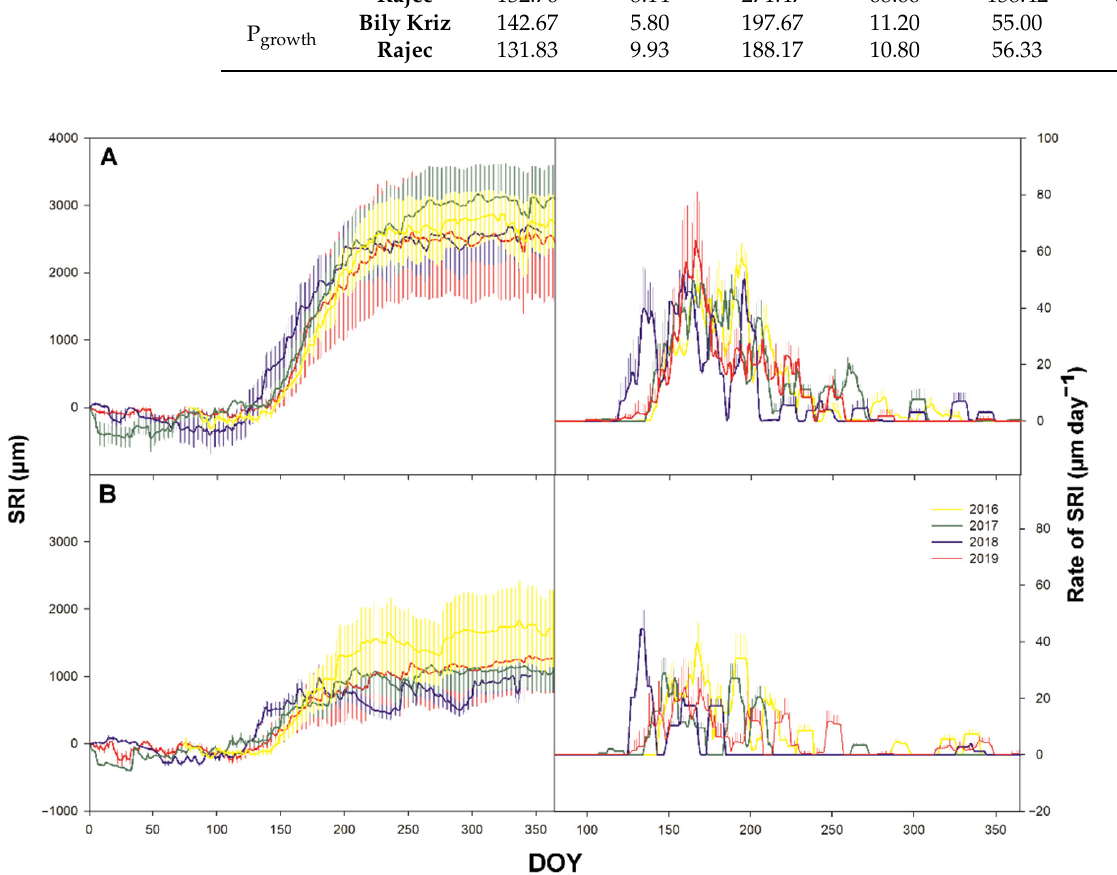
Figure 5. Time series of cumulative daily secondary growth expressed by stem radial increment (SRI) in µ m ( left ) and time series of daily rate of SRI in µ m day − 1 (at the studied plots Bily Kriz ( A ) and Rajec ( B ) in 2016–2019. Vertical bars represent standard deviation.